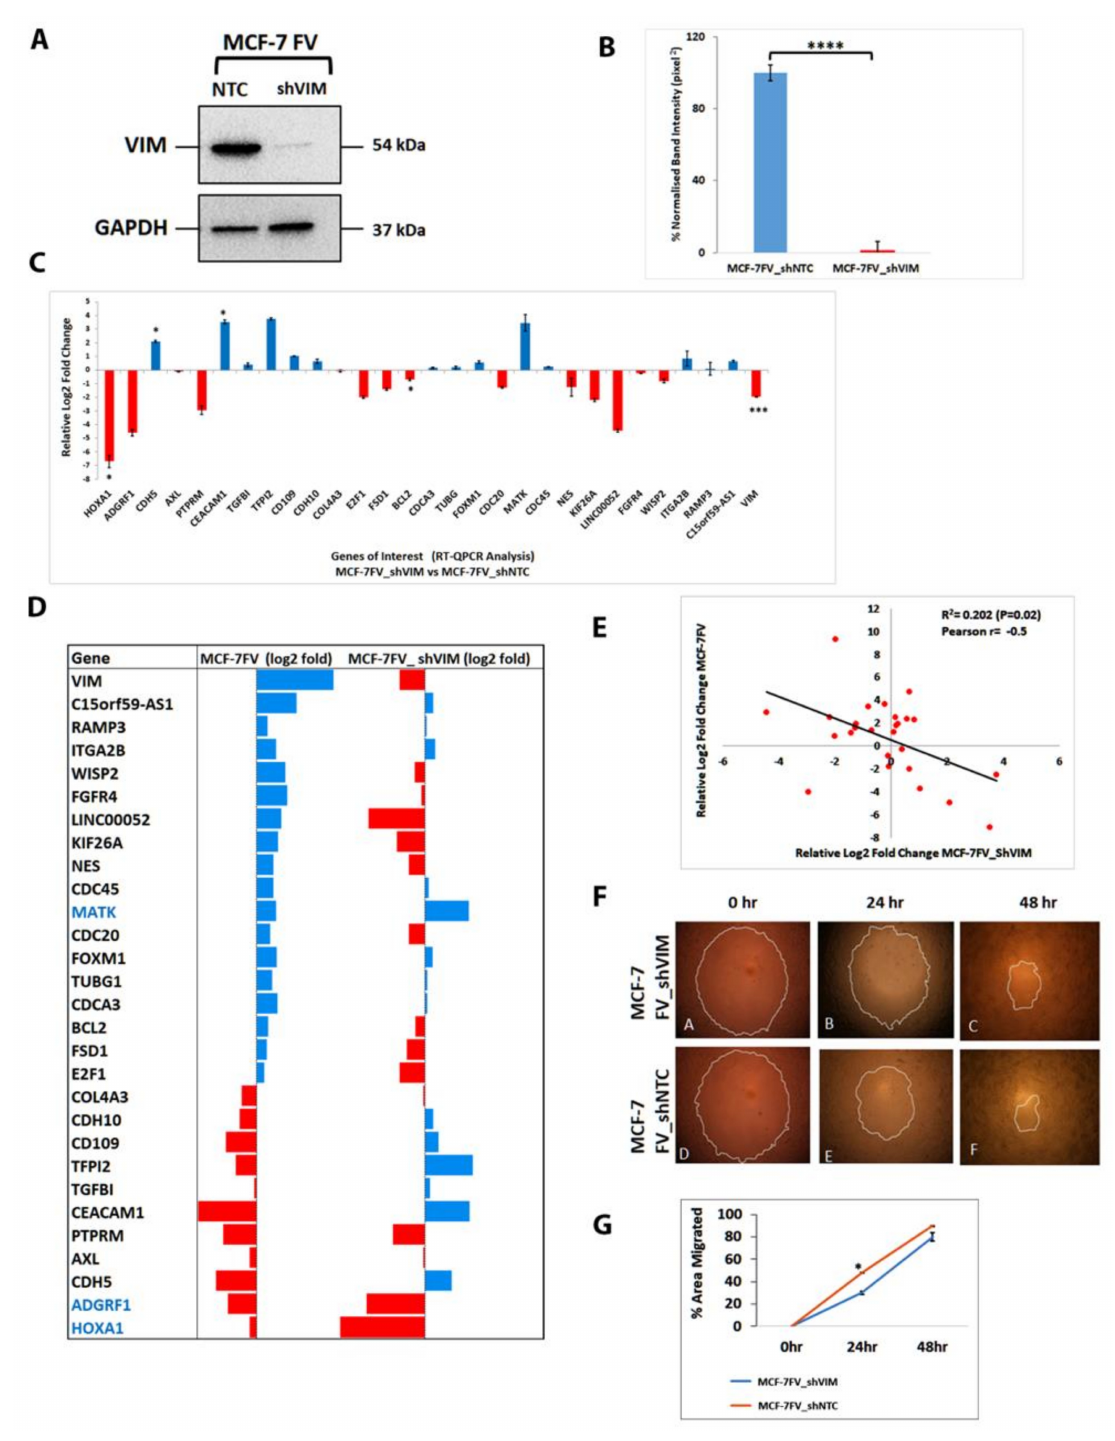
Figure 4. Knockdown of vimentin in MCF-7FV by shRNA. ( A ): Vimentin expression in MCF- 7FV_shVIM and MCF-7FV_shNTC by Western blotting. Five µ g protein was loaded for both the cell types. GAPDH was used as the loading control. Relevant bands were cropped from different gels and regrouped. Original blots are shown in Supplementary Figure S6 ( B ): Quantification of vimentin expression in MCF-7FV_shVIM and MCF-7FV_shNTC using ImageJ , Note the expression of vimentin was downregulated by 95% ± 3.6 in MCF-7FV_shVIM compared with MCF-7FV_shNTC. ( C ): Log2-fold change expression of DEGs of interest in MCF-7FV_shVIM relative to MCF-7FV_shNTC. ( D ): Comparison of patterns of log2-fold change of DEGs of interest in MCF-7FV and